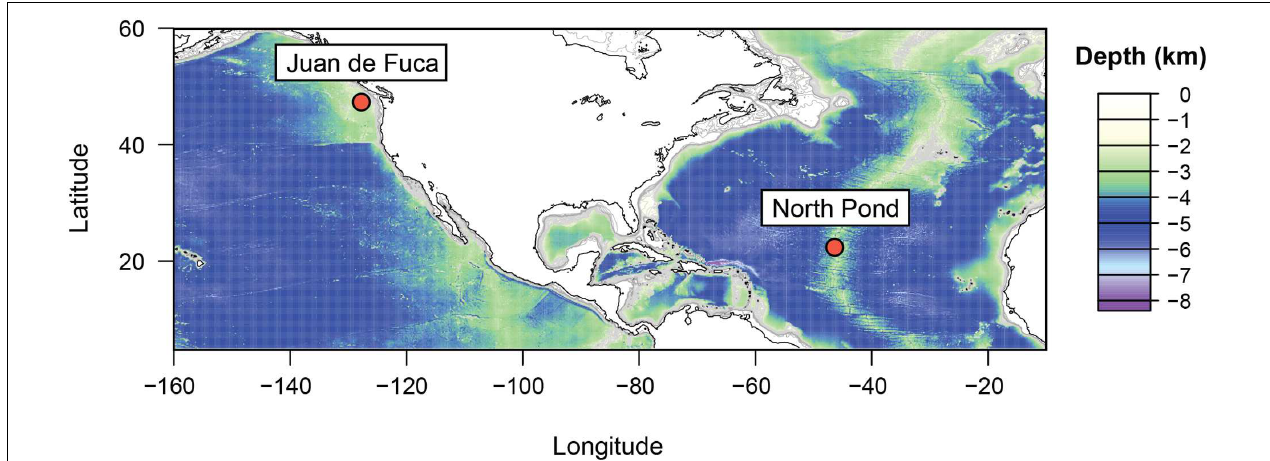
FIGURE 1 | Location of CORK observatory sampling sites on the Juan de Fuca Ridge flank, Pacific Ocean (47 ◦ 45.6 (cid:48) N, 127 ◦ 45.6 (cid:48) W) and the North Pond, Atlantic Ocean (22 ◦ 48.1 (cid:48) N, 46 ◦ 03.2 (cid:48) W).